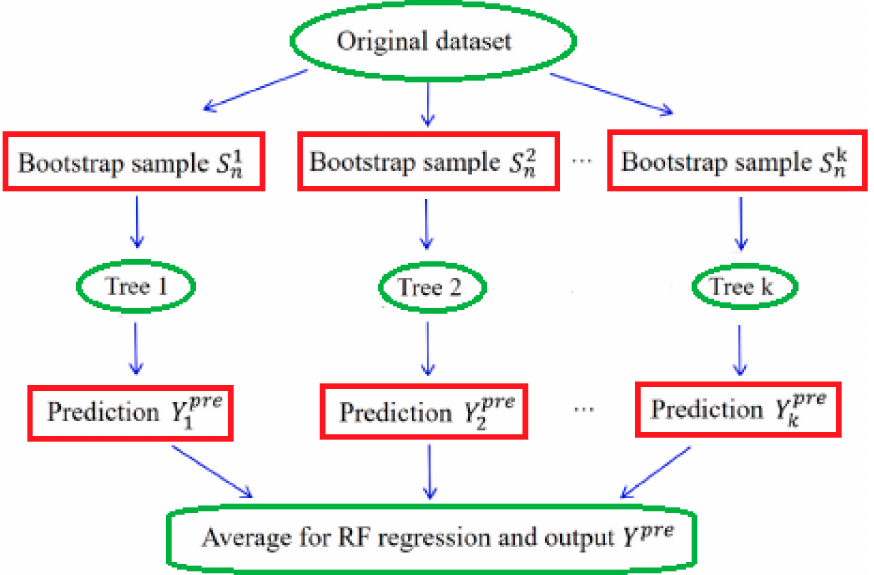
Figure 5. Flow chart of RF regression consisting of bootstrap samples and trees. S nk represents the samples used for training by the bootstrap algorithm, and Y pre represents the predicted value.